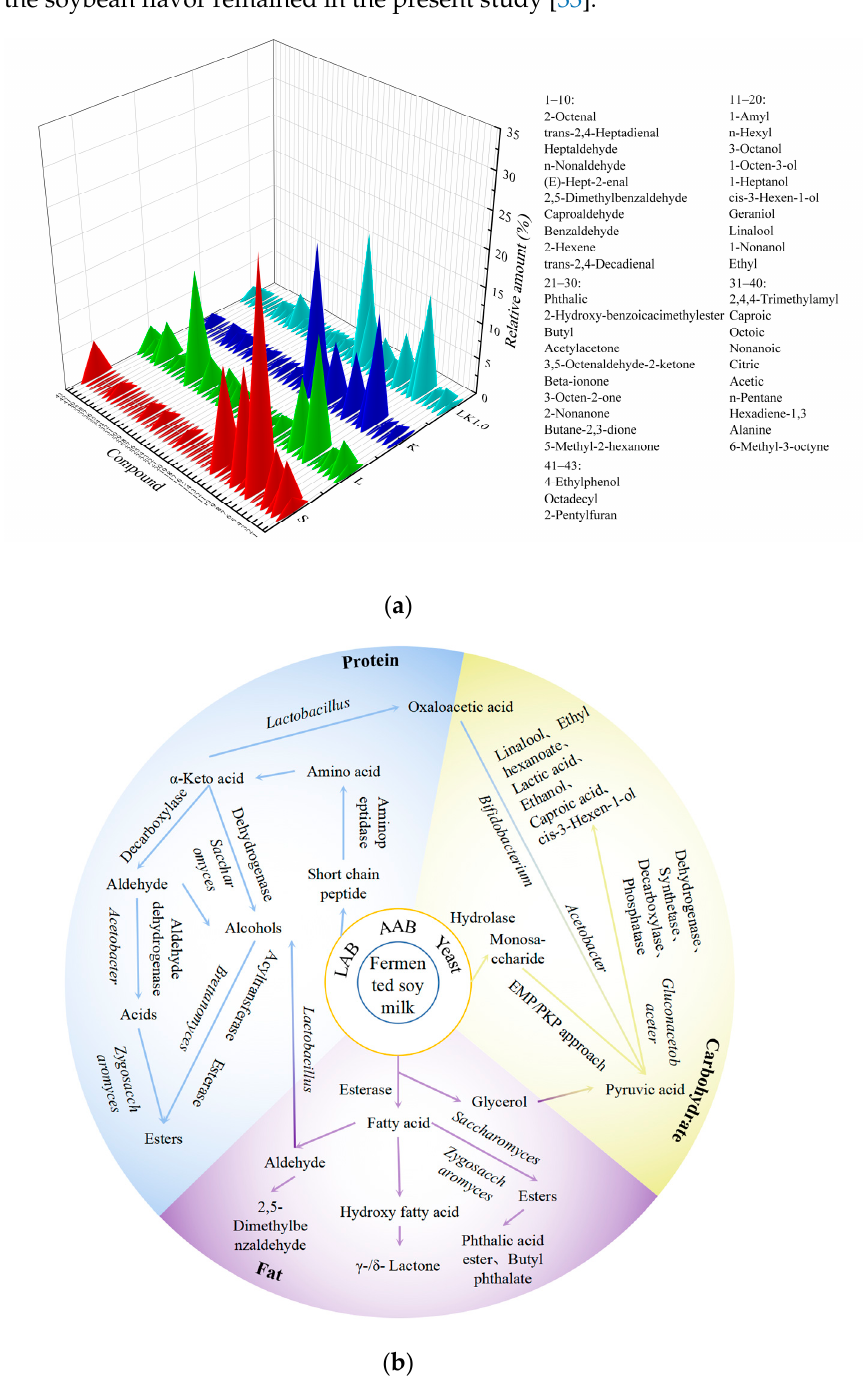
Figure 7. ( a ) Volatile flavor components in fermented soy milk. S = unfermented soy milk. ( b ) Main formation pathways for the flavor substances, blue: Protein metabolism; yellow: Carbohydrate metabolism; purple: Fat metabolism.